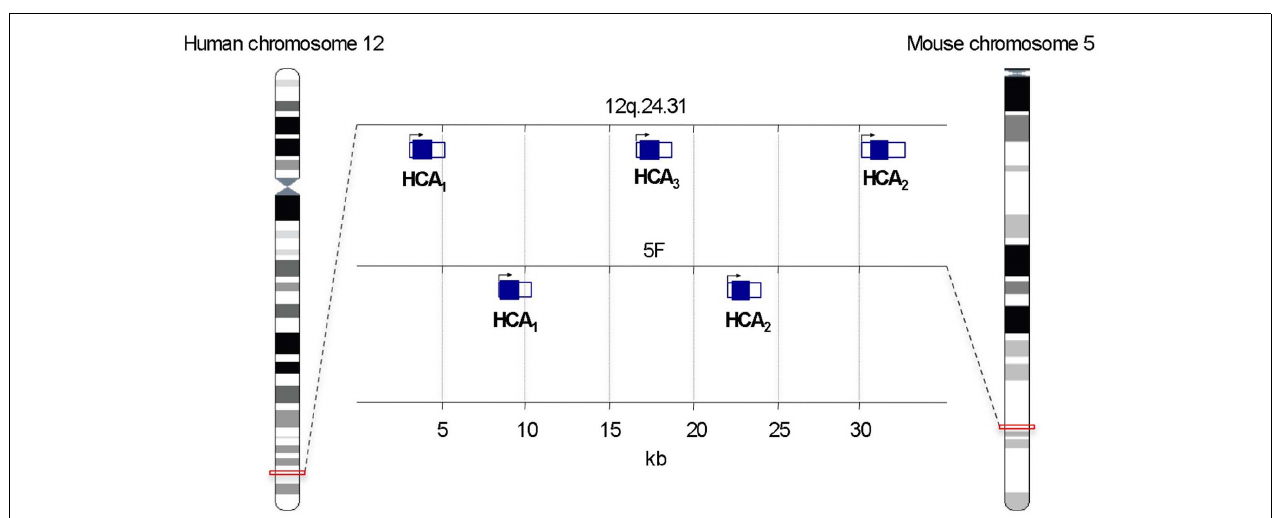
FIGURE 1 | Schematic representation of the chromosomal location of genes encoding hydroxy-carboxylic acid (HCA) receptors. Protein-coding sequences are shown by filled rectangles. Adapted from Ensembl Genome Browser.